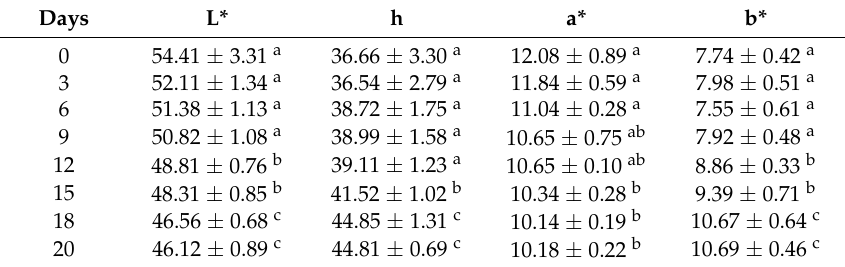
Table A3. Color parameters of boiled pork hams during refrigerator storage.